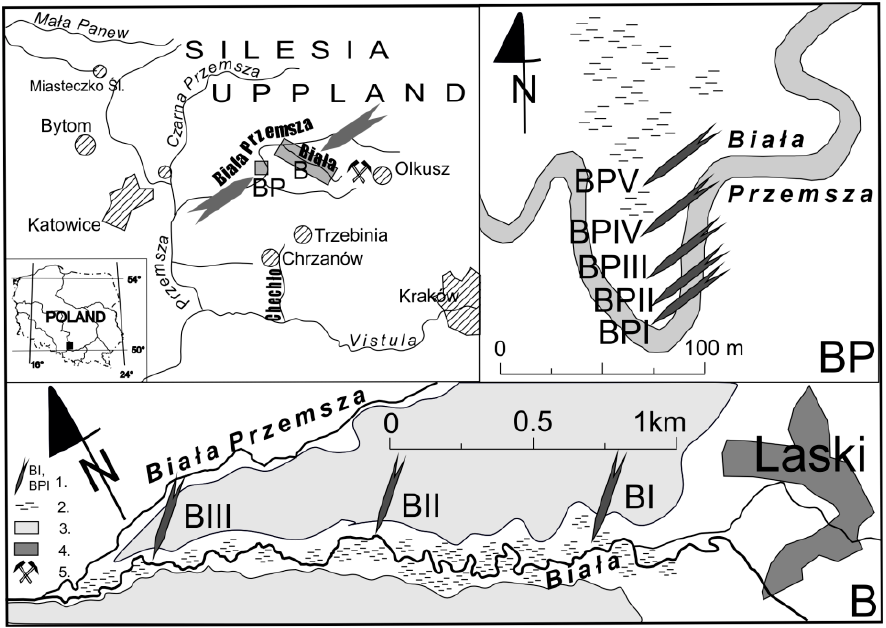
Figure 1. Location of research area and sampling sites; 1. Sampling site, 2. Wetlands, 3. Forests, 4. Buildup area, 5. Zn–Pb